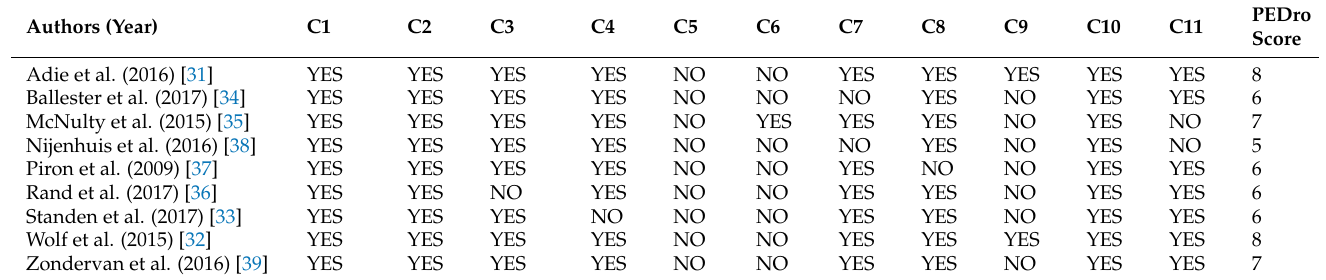
Table 2. Quality assessment of selected randomized controlled trials using the Physiotherapy Evi- dence Database (PEDro) scale: a higher score implies improved